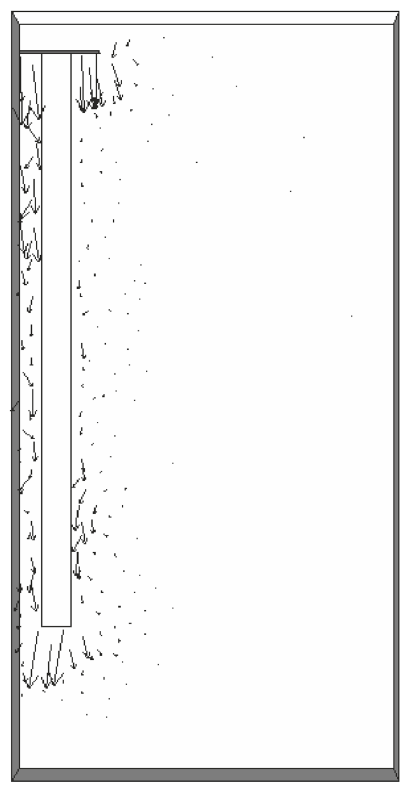
Figure 14: The soil displacement field of the pile group with 3 b pile spacing in the DEM